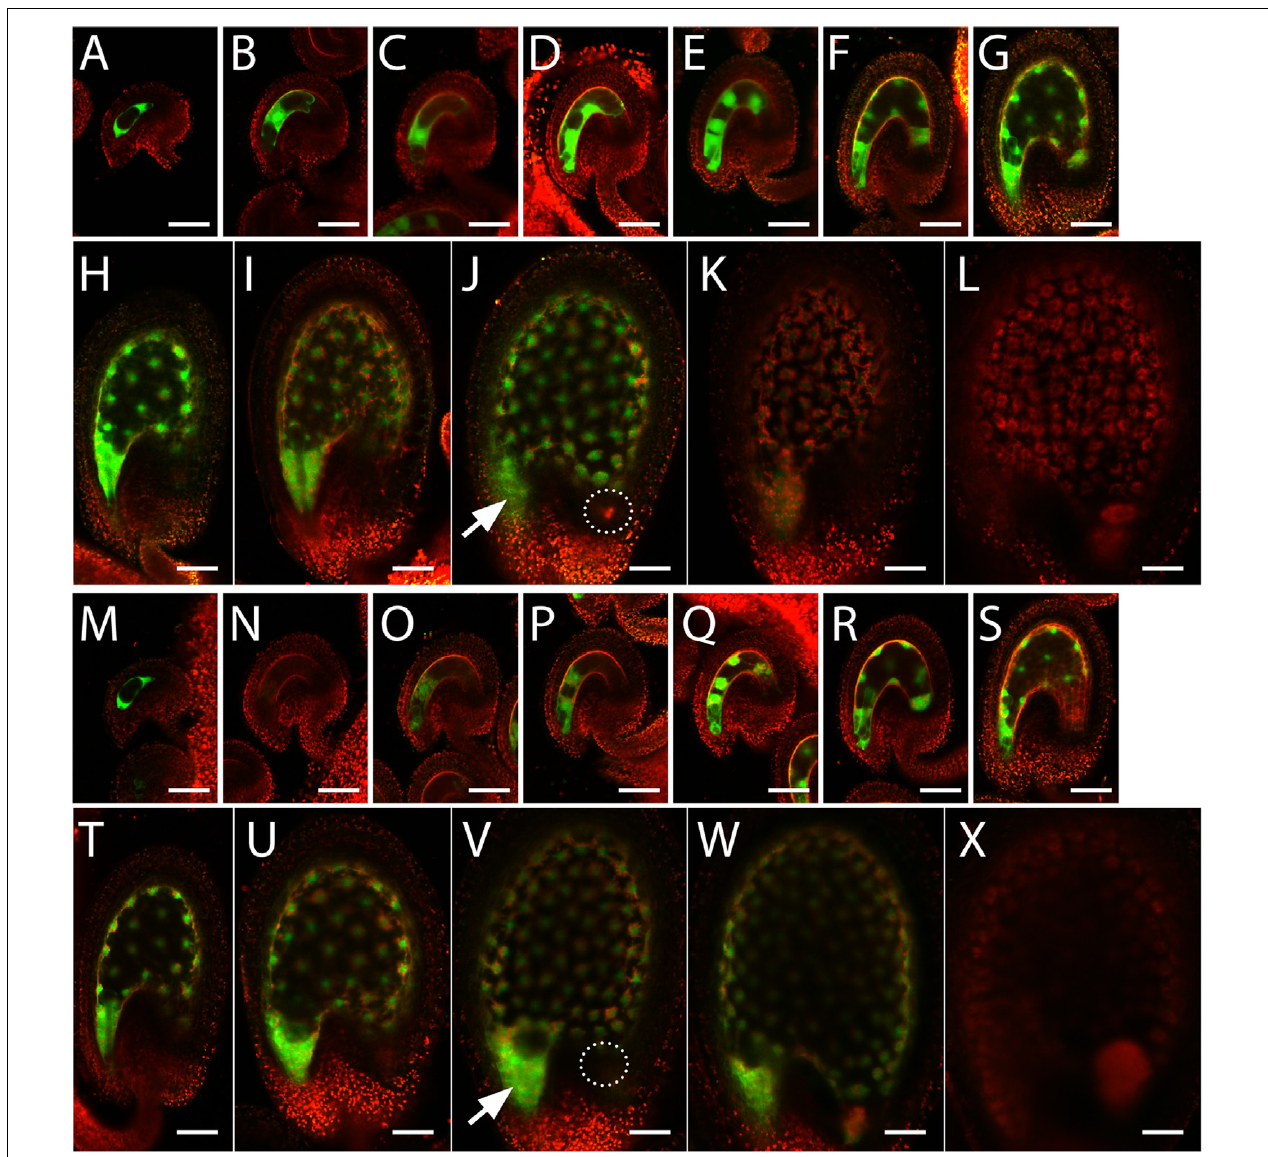
FIGURE 3 | InvINH1 and InvINH2 promoter activity in the female gametophyte and the endosperm. Promoter-GFP fusions for InvINH1 (A–L) and InvINH2 (M–X) were analyzed by confocal microscopy in the ovules isolated from stage 12 flowers (Smyth et al., 1990) containing stage FG4 (Christensen et al., 1997) female gametophyte (A,M) and from flowers at 1 day after emasculation (B,N) . The GFP signals in the fertilized seeds were analyzed at endosperm stage I (C,O) , II (D,P) , III (E,Q) , IV (F,R) , V (G,S) , VI (H,T) , VII (I,U) , VIII (J,V) , and IX (K,W) (Boisnard-Lorig et al., 2001), as well as in seeds containing heart stage embryos (L,X) . The embryo stage in (L,X) was verified by dissection. GFP (green) and auto-fluorescent signals (red) were imaged simultaneously and merged. All the images were oriented with the micropylar ends on the left and the chalazal ends on the right. Arrow indicates micropylar endosperm. Dashed circle indicates the location of chalazal endosperm. Bar = 50 µ